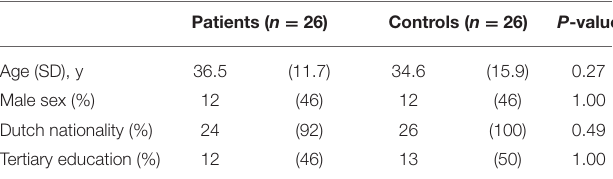
TABLE 1 | Demographic data of OCD patients and healthy